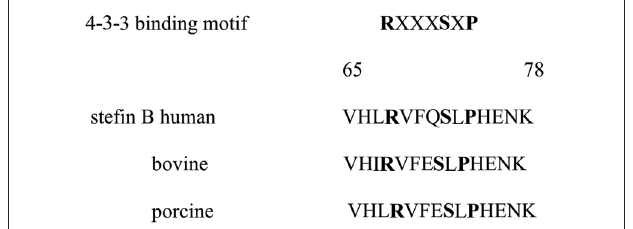
FIGURE 6 | Stefin B species variants contain putative 14-3-3 binding